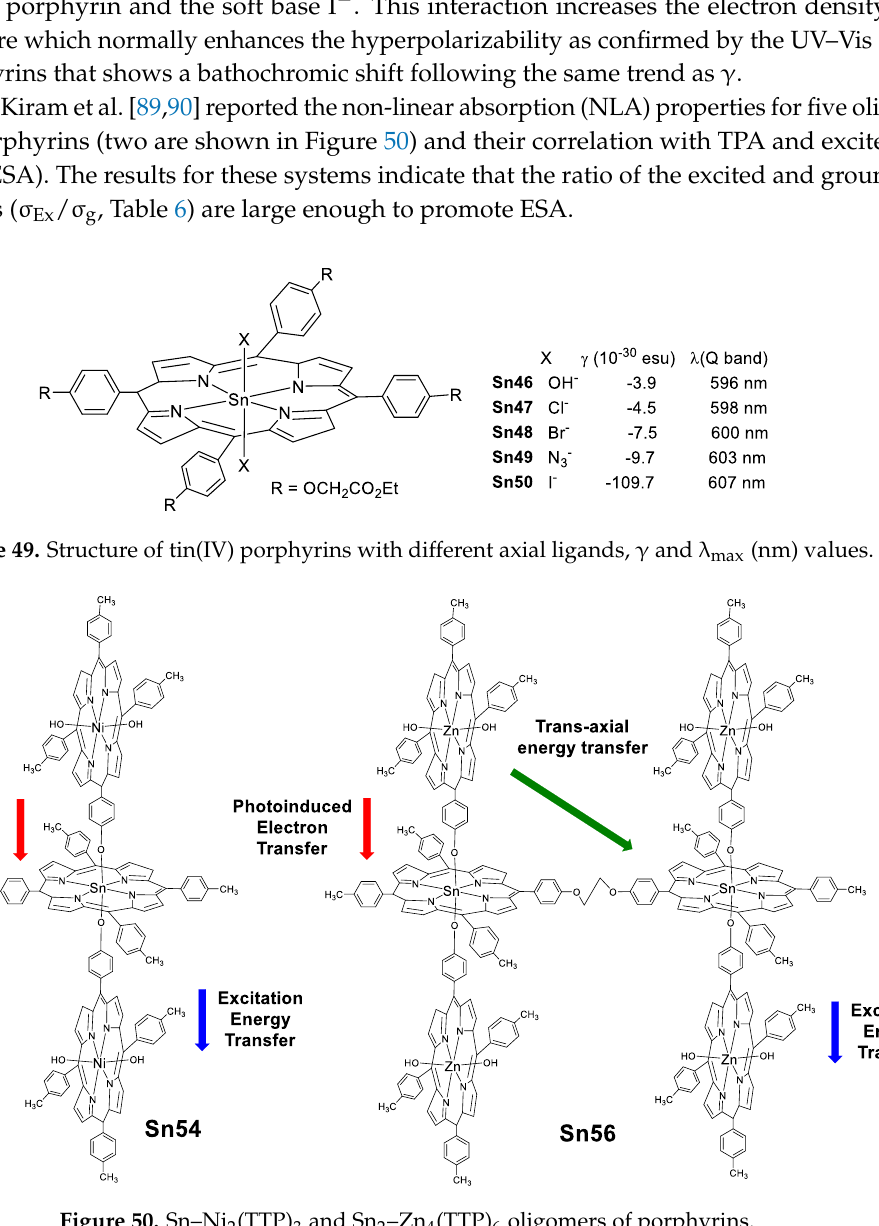
Figure 50. Sn–Ni 2 (TTP) 3 and Sn 2 –Zn 4 (TTP) 6 oligomers of porphyrins.